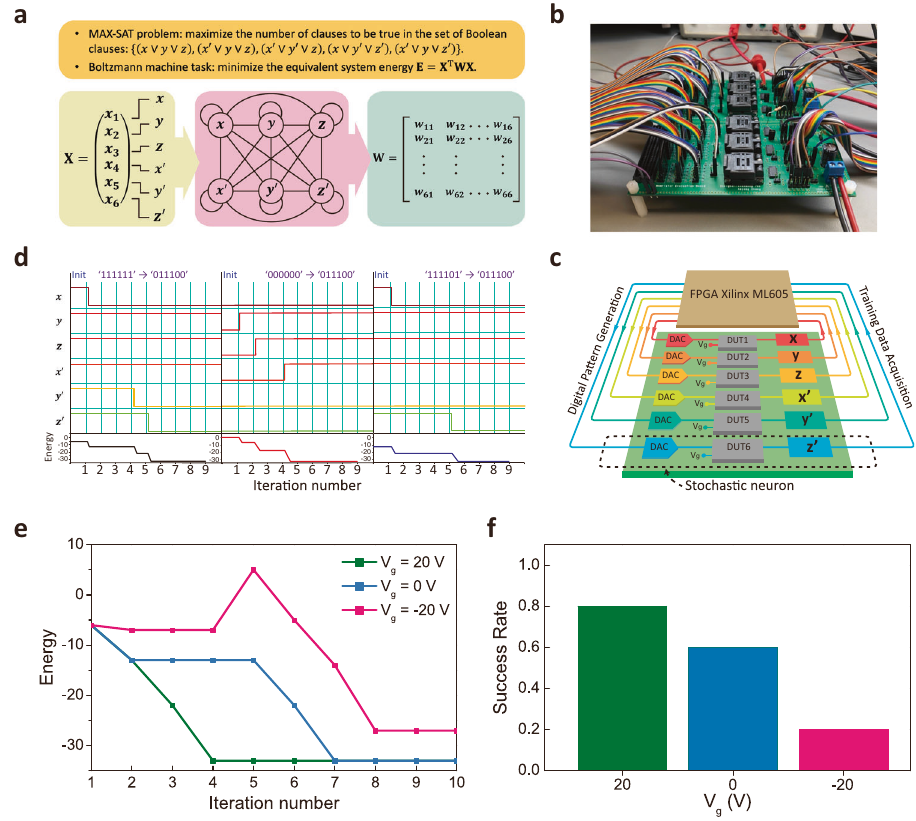
Fig. 3 Boltzmann machine implementation using tin oxide/MoS 2 heteromemristor. a Flow chart showing the steps in mapping a MAX-SAT problem to an equivalent form solvable using the Boltzmann machine. b The PCB evaluation board of BM-integrated system, including the packaged tin oxide/MoS 2 memristive units and CMOS peripheral circuits. c Schematic of the BM circuit blocks with six tin oxide/MoS 2 heteromemristors as the arti fi cial neurons. d The experimentally obtained evolution of state vector and total energy when the BM was started from three different initial states, resulting in the same optimal solution. e Experimentally obtained energy evolution in the BM optimization process with V g = − 20 V, 0 V, and 20 V, respectively. f The success rate of the BM optimization process under different V g